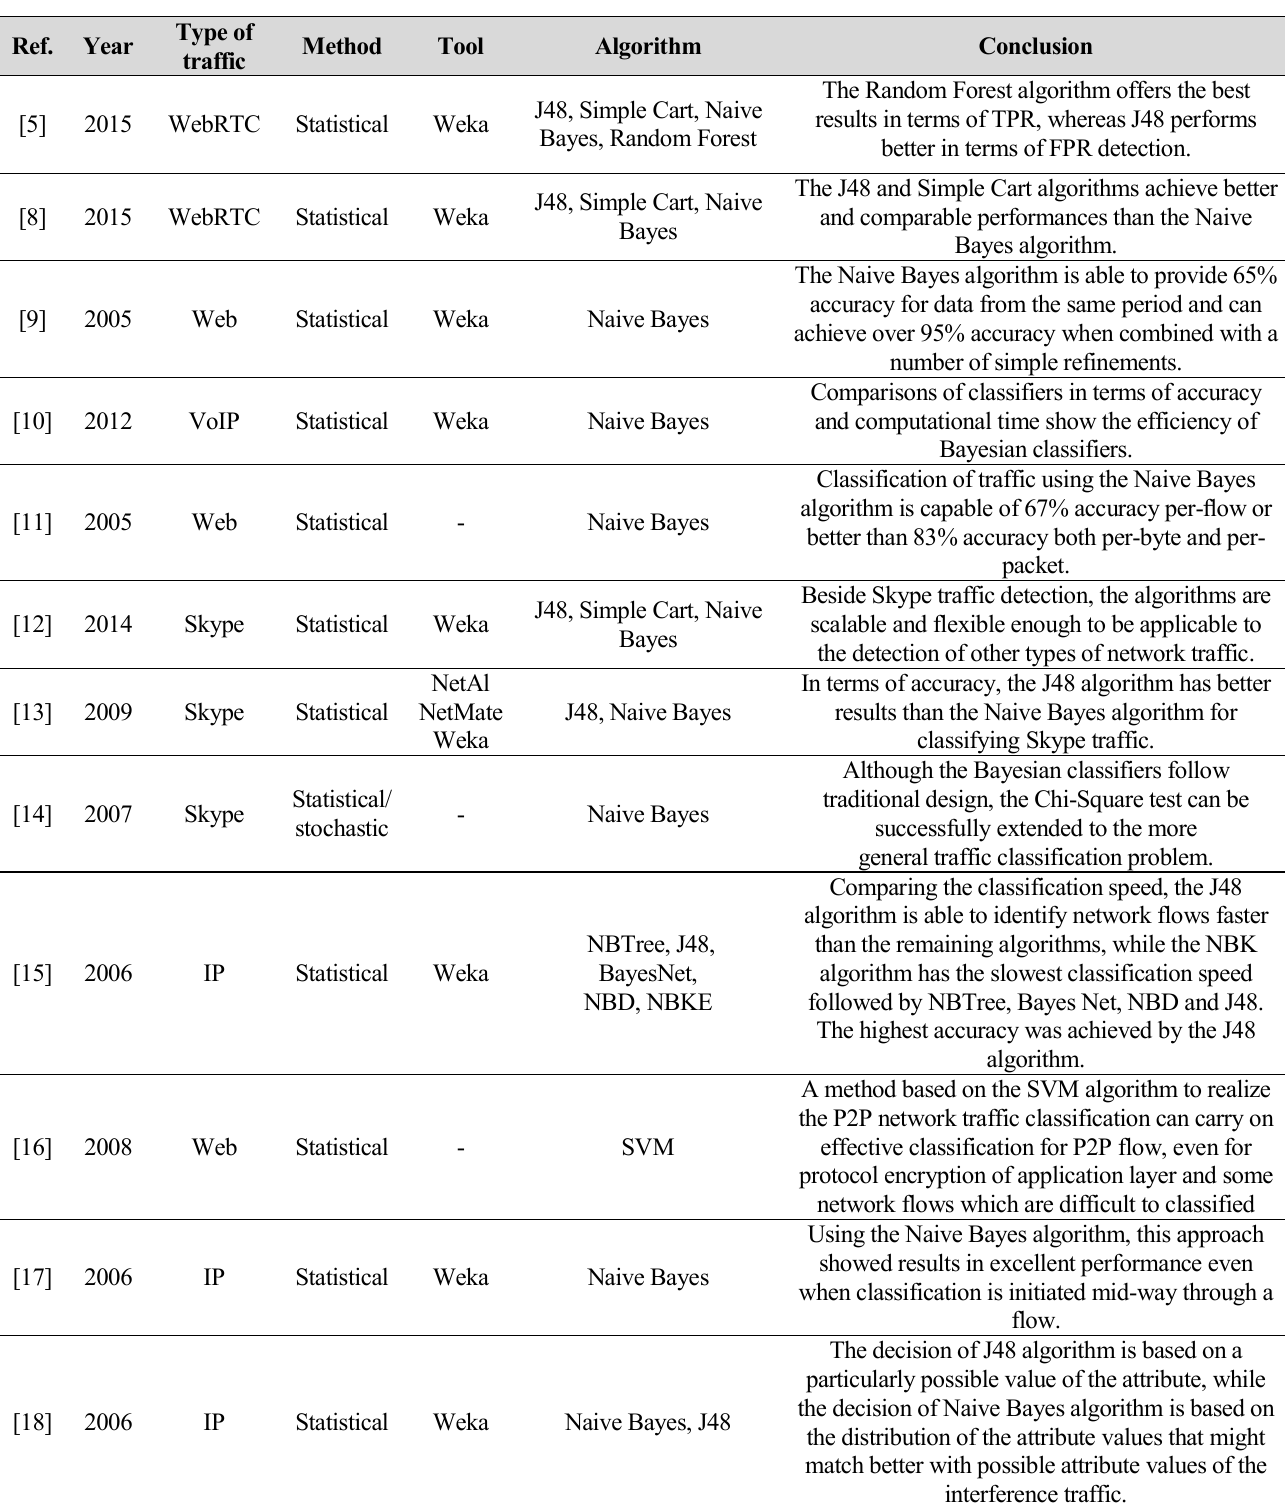
Table 1. Related work on traffic